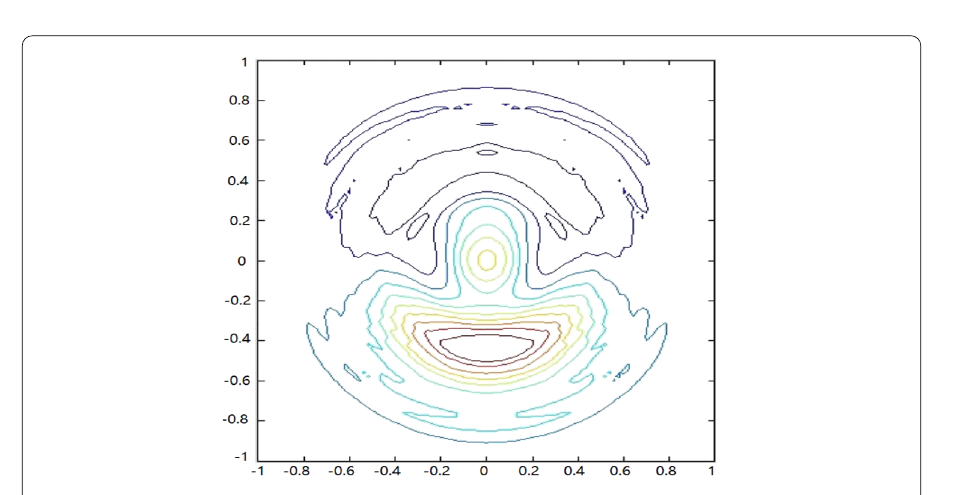
Figure 2 The CCS solution when t = 1.0